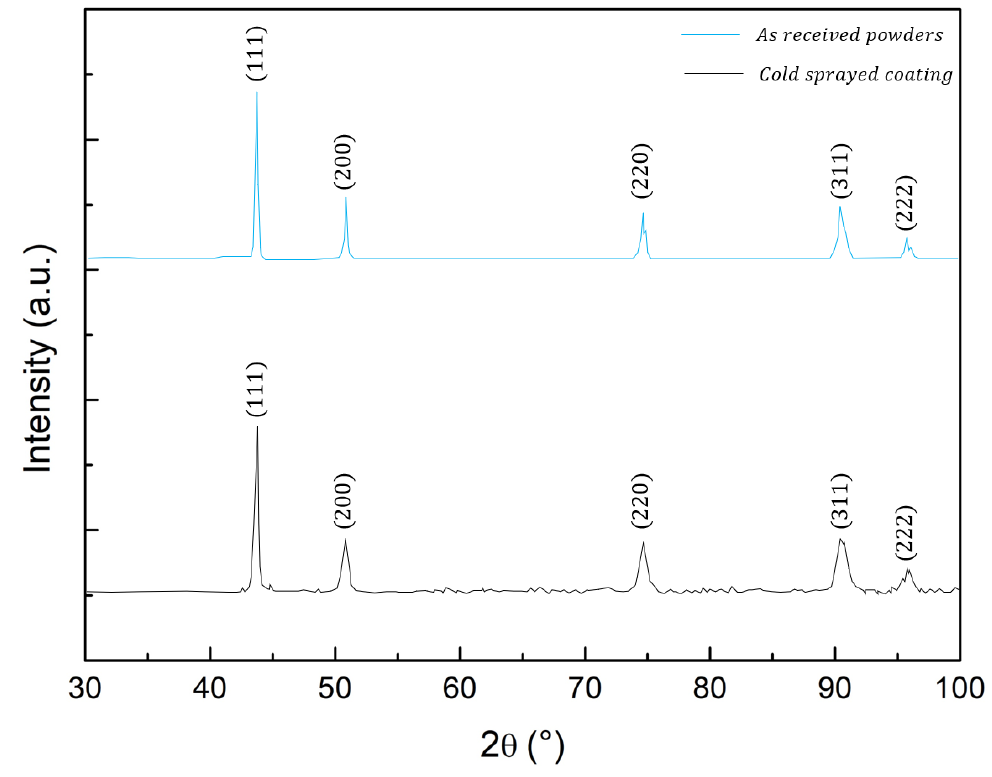
Metals 2022 , 12 , 780 Figure 5. XRD profiles of the as-received powders and of the coating. Figure 5. XRD profiles of the as-received powders and of the coating. The coating microstructure characterized through transmission electron microscopy revealed grain refinement due to the severe plastic deformation experienced by the parti- cles during splatting (Figure 6).